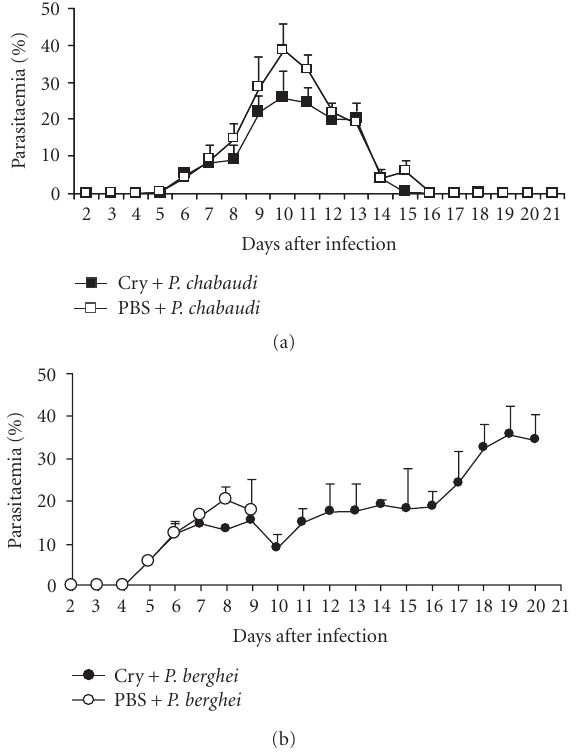
Figure 1: E ff ect of Cry1Ac on parasitaemia in CBA/Ca mice. Groups of eight mice were treated with Cry1Ac protoxin once a week for four weeks. One day after the last injection, mice were infected with P. chabaudi AS (a) or P. berghei ANKA (b). Groups of control mice were treated with PBS. Data are representative of two separate experiments.